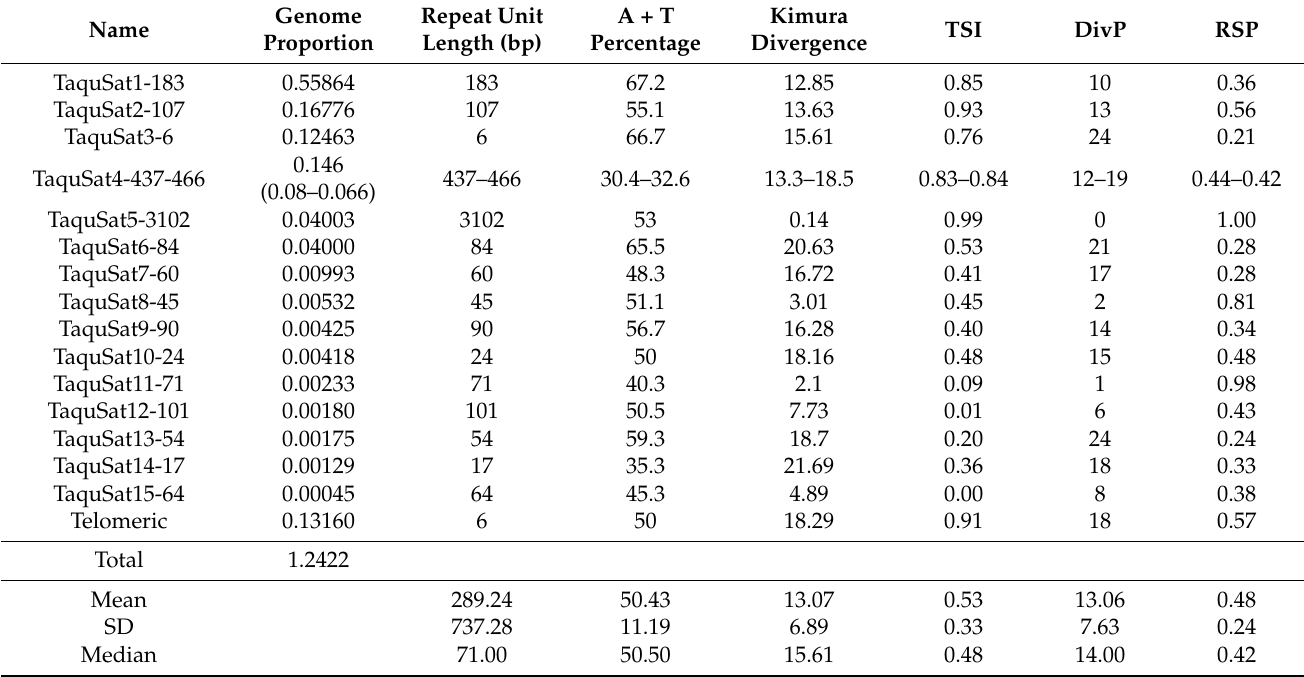
Table 1. Data of the satDNA families found in T. aquitania : genome proportion (%), the repeat unit length, A + T content and divergence (%), tandem structure index (TSI), divergence peak (DivP) and relative abundance size of the peak